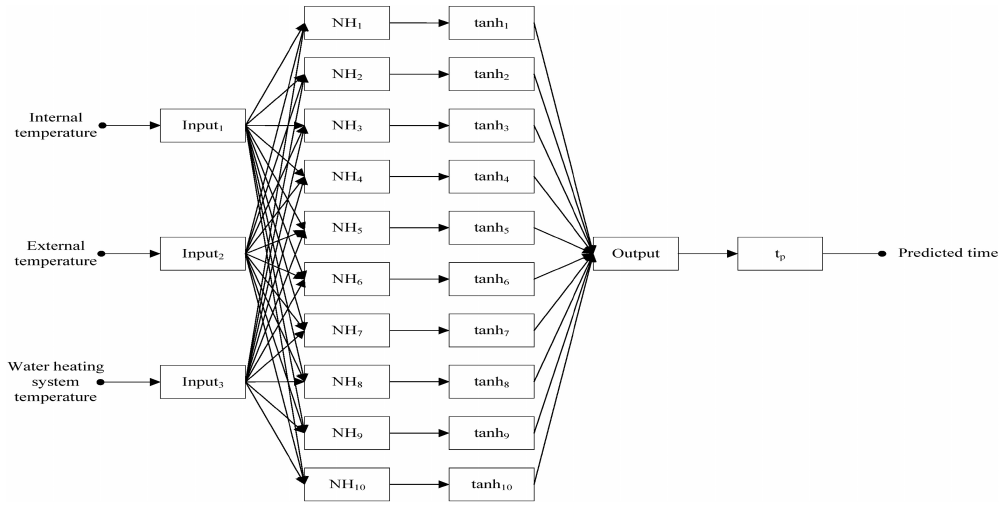
Figure 2. Artificial neural network implementation